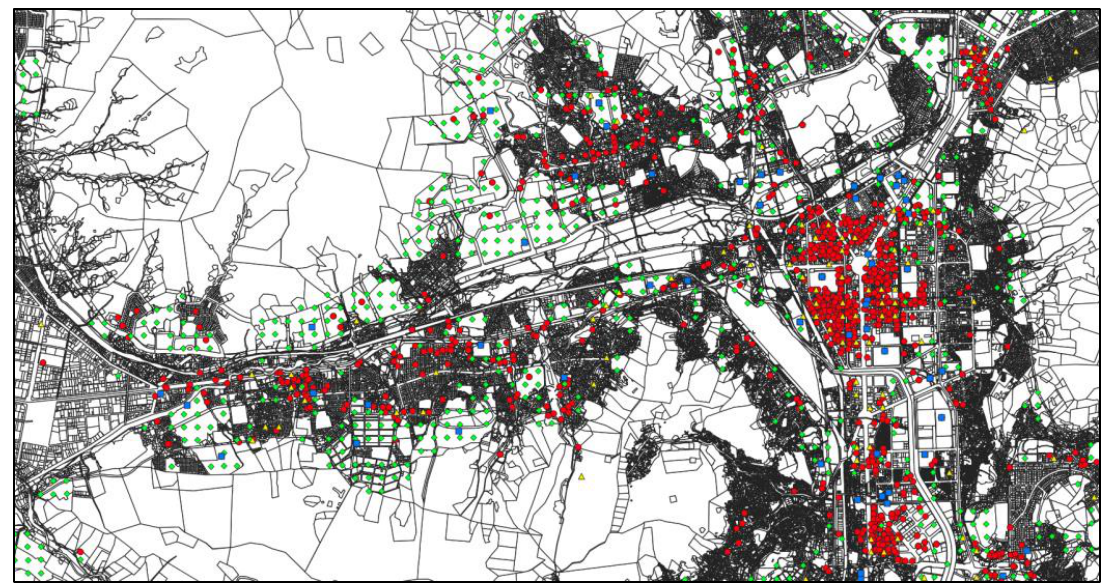
Figure 6. An area in Busan marked with entities of interest (red circles: restaurant businesses; green diamonds: residential complexes; yellow triangles: convenience stores; blue squares: large shopping malls).